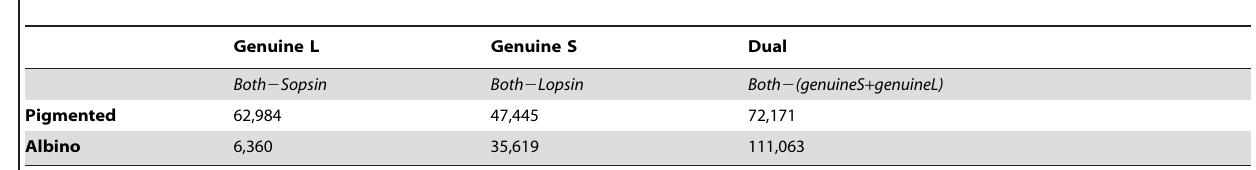
With data from table 1, the population of genuine L, genuine S, and dual cones was inferred (see column headlines).